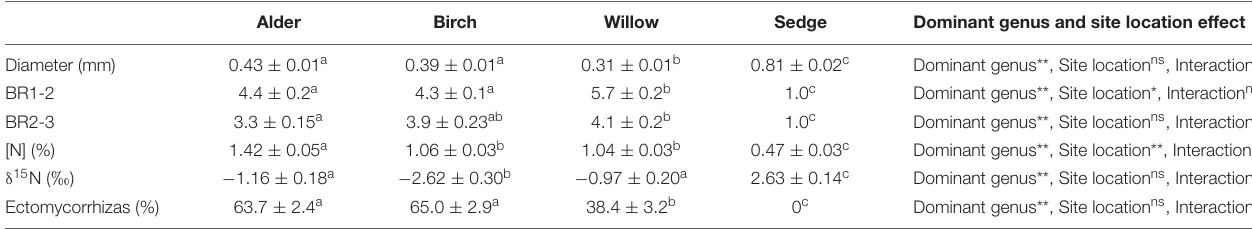
TABLE 2 | Root morphology, architecture, chemistry, and mycorrhizal colonization of four different vegetation types in Northern Alaska, United States. Alder Birch Willow